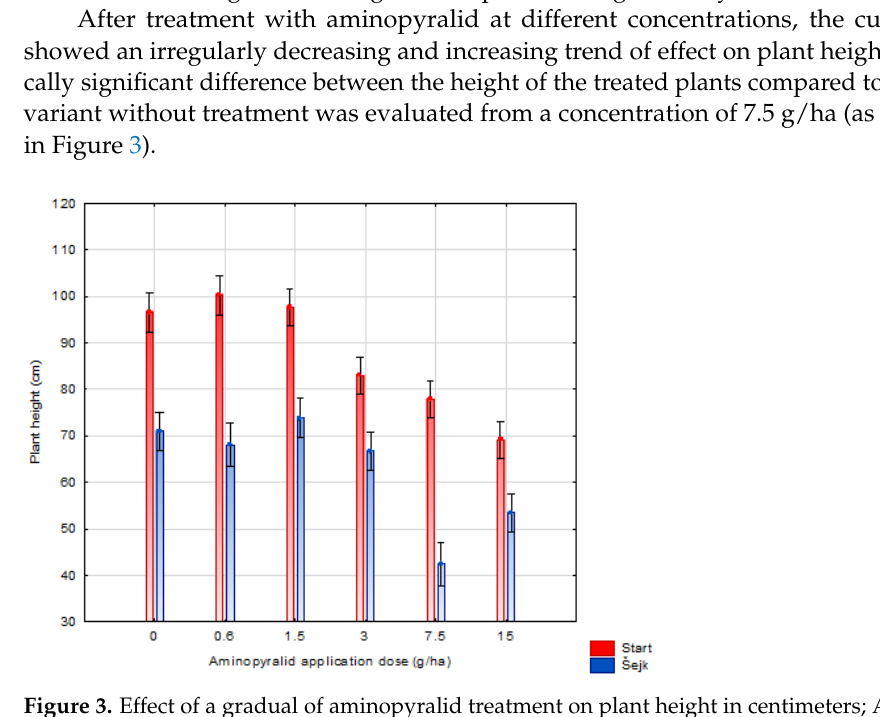
Figure 3. Effect of a gradual of aminopyralid treatment on plant height in centimeters; ANOVA with Fisher´s LSD post hoc test (α = 0.05; n = 10), bar is a standard deviation, significantly different classes of values were added in separate Table S2 in Supplementary Materials.